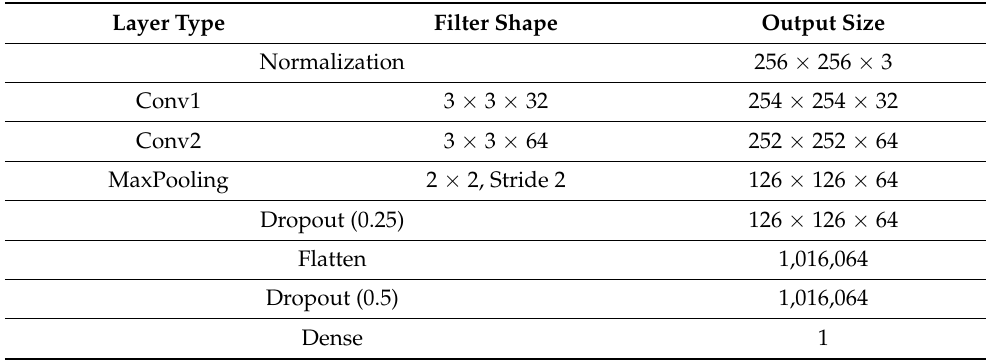
Table 8. Model architecture selected by